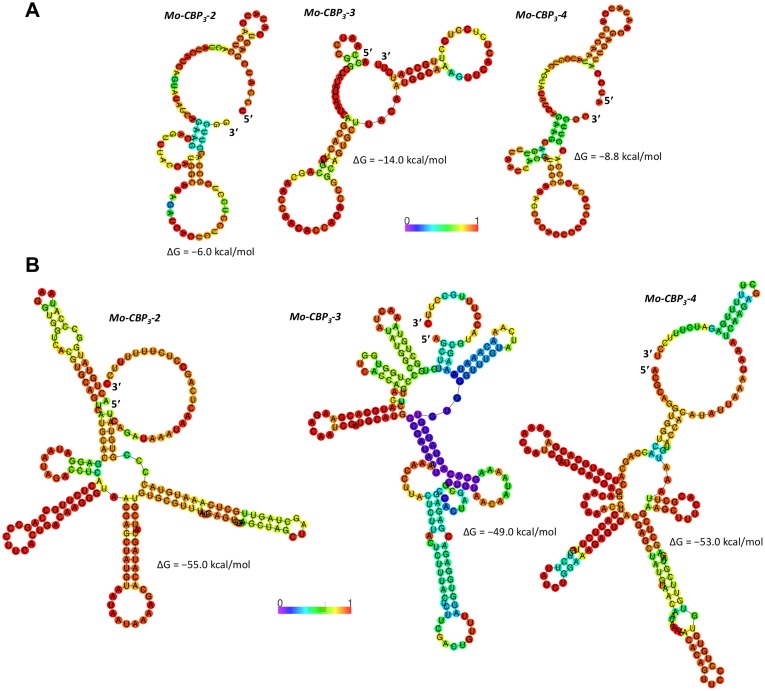
Predicted secondary structures of the 5′ UTR and 3′ UTR sequences of the Mo-CBP
3 mRNAs.A. The predicted MFE secondary structures of the entire 5′ UTR and the first 32 nt of the CDS of the Mo-CBP
3–2, Mo-CBP
3–3 and Mo-CBP
3–4 mRNAs are shown. B. The predicted MFE secondary structures of the entire 3′ UTRs of the Mo-CBP
3–2, Mo-CBP
3–3 and Mo-CBP
3–4 mRNAs are shown. Heat color gradation from blue to red represents the base-pairing probability from 0 to 1.